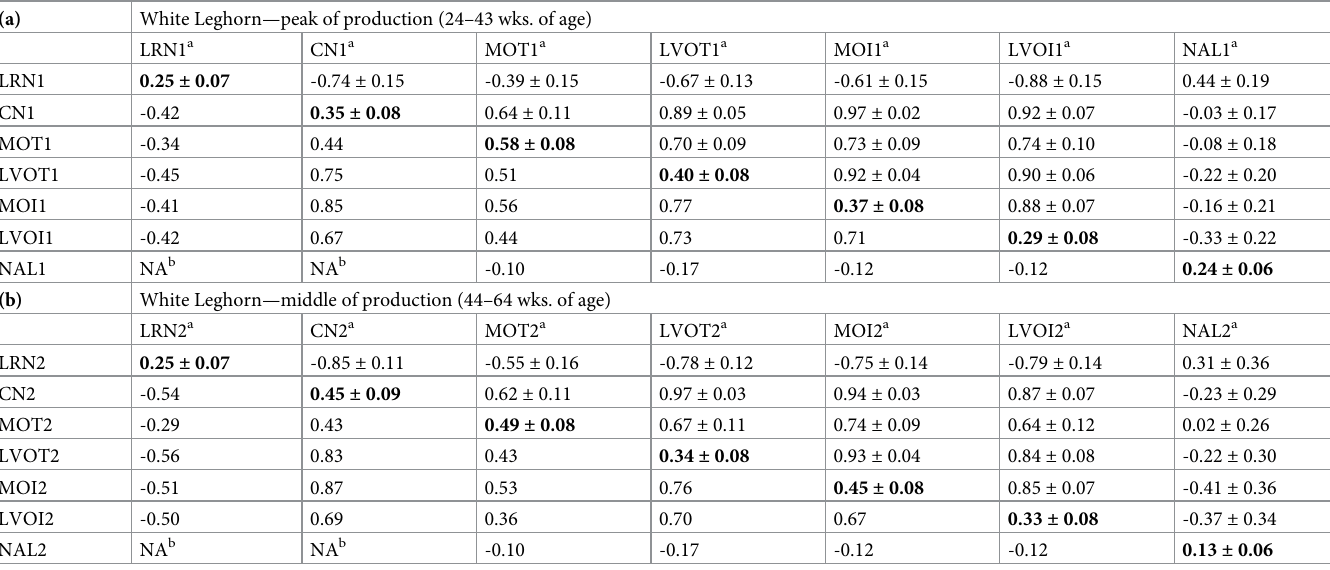
a LRN, laying rate in the nests; CN, clutch number; MOT, mean oviposition time; LVOT, logarithm of the variance of oviposition time; MOI, mean oviposition interval; LVOI, logarithm of the variance of oviposition interval; NAL, nest acceptance for laying. The number after abbreviations indicates the breeding period: 1 for the peak and 2 for the middle production. b